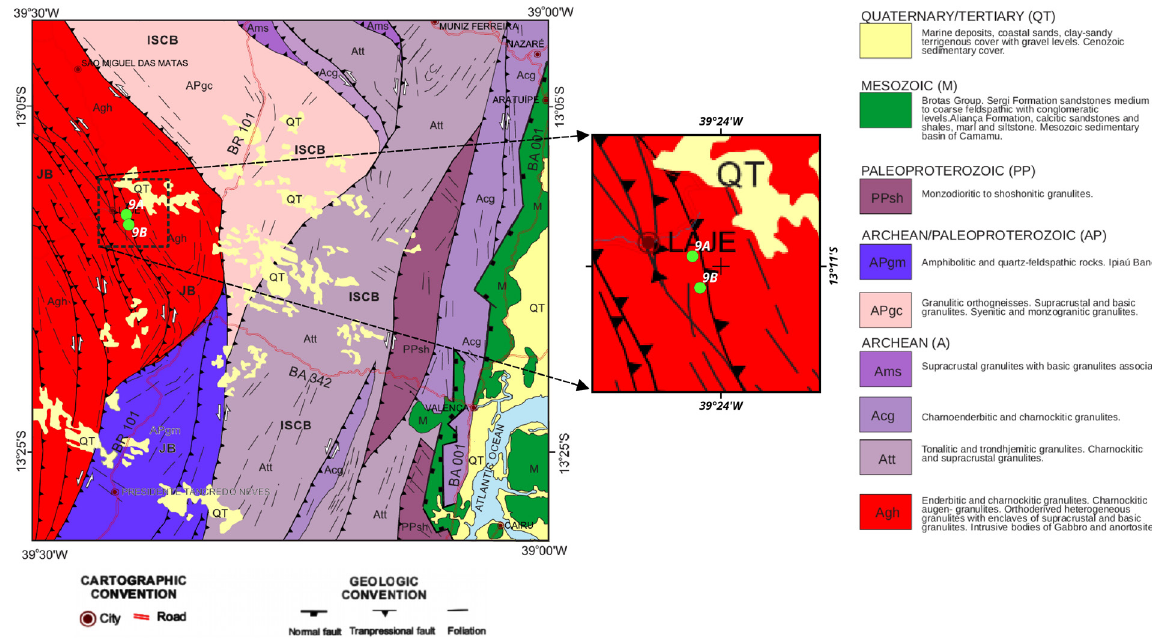
Figure 1. Geological map and legend of the Valença sheet adapted from a map at a scale 1:250,000. Points 9A and 9B are the extreme points of the profile selected for ground-truth investigation. The quadrangle indicates the location of the area of the detailed geophysical